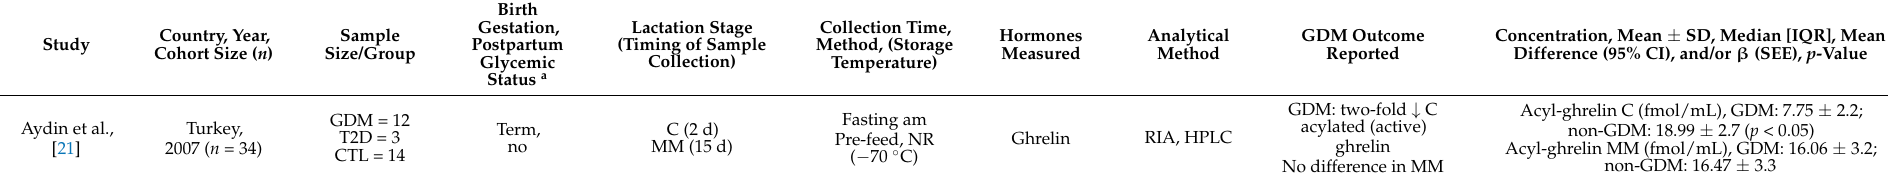
Table 1. Summary of studies examining human milk metabolic hormones from lactating women who have had gestational diabetes